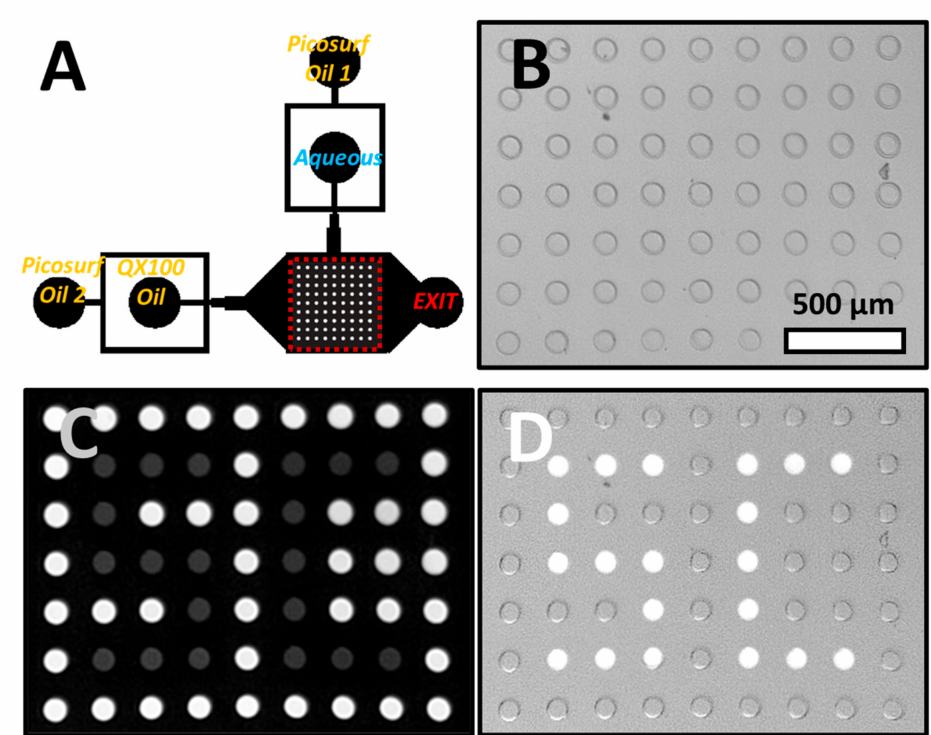
Figure 2. ( A ) Array device channel geometry. The location of the droplet array is highlighted by a dashed red square. ( B ) Bright-field image of droplet array. All wells are occupied with droplets that are approximately the same size as the wells. ( C ) Fluorescence from blue excitation. Irradiated droplets have lower fluorescence intensity. ( D ) Droplet array after the elution of non-irradiated droplets. Fluorescence excitation light was used in combination with bright-field image to increase droplet